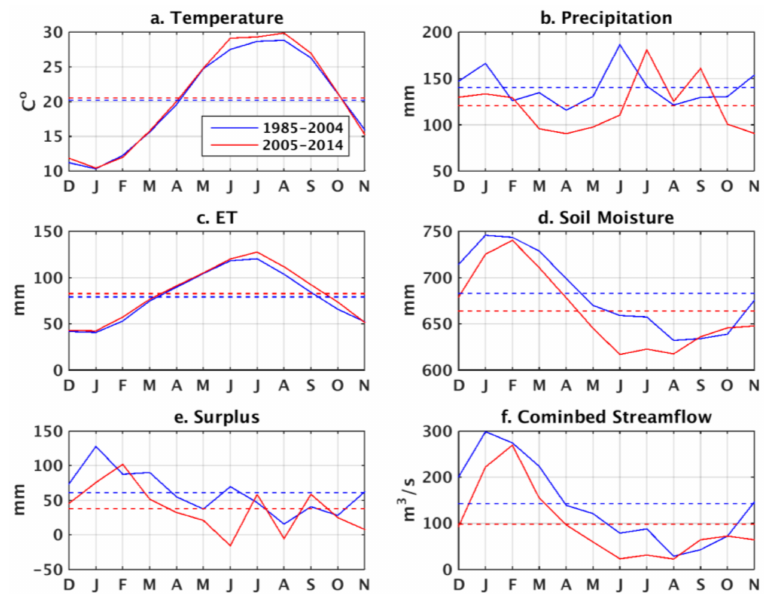
Figure 12. Comparison of monthly climatology for the period of 1985–2004 (blue) against that of the period of 2005–2014 (red) for ( a ) temperature, ( b ) precipitation, ( c ) evapotranspiration, ( d ) soil moisture, ( e ) water surplus, and ( f ) combined streamflow at USGS 08015500, 08012150, and 07386980. The dashed line is the annual mean